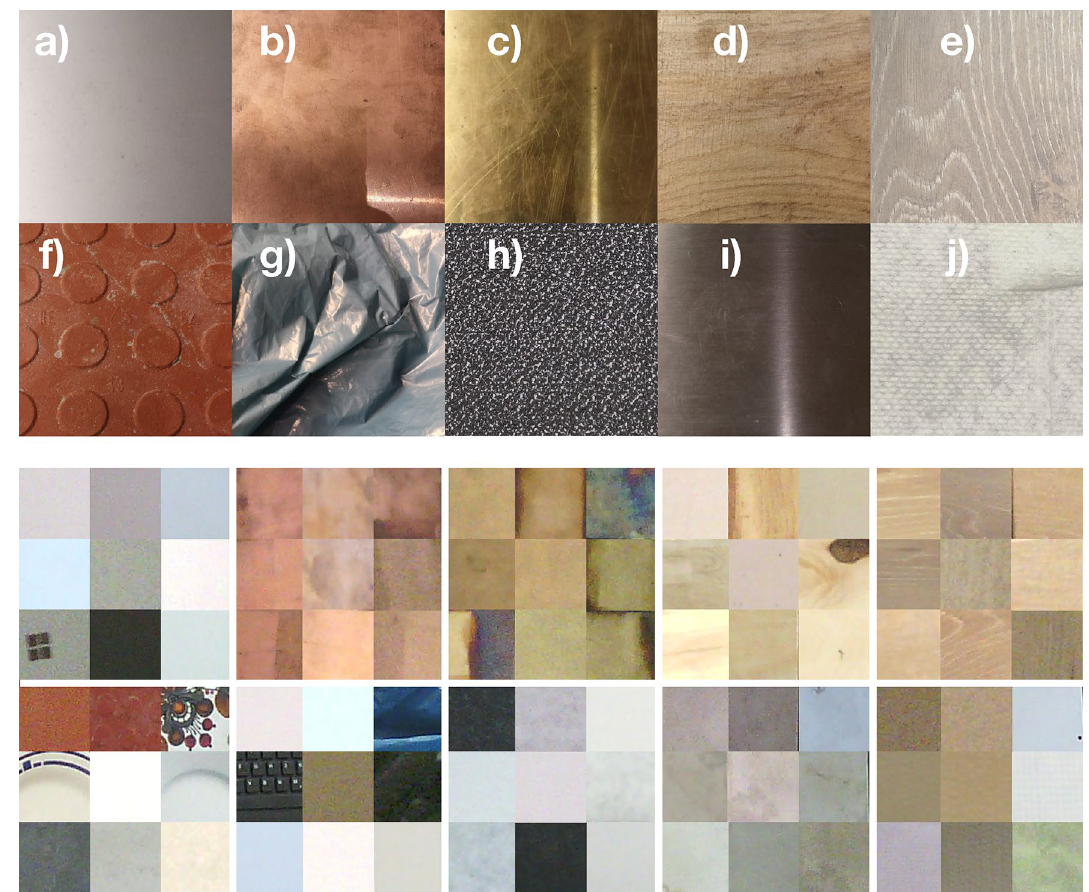
Figure 1. Material classes and samples of the database used. The first two rows show some material samples: ( a ) Aluminum, ( b ) Copper, ( c ) Brass, ( d ) Wood, ( e ) Wood Imitations, ( f ) Ceramics, ( g ) Plastics, ( h ) Textiles, ( i ) Stainless Steel, ( j ) Cellulose. Some cropped images are shown in the same order in the lower two rows. These images were used for training and evaluation of the CNN.